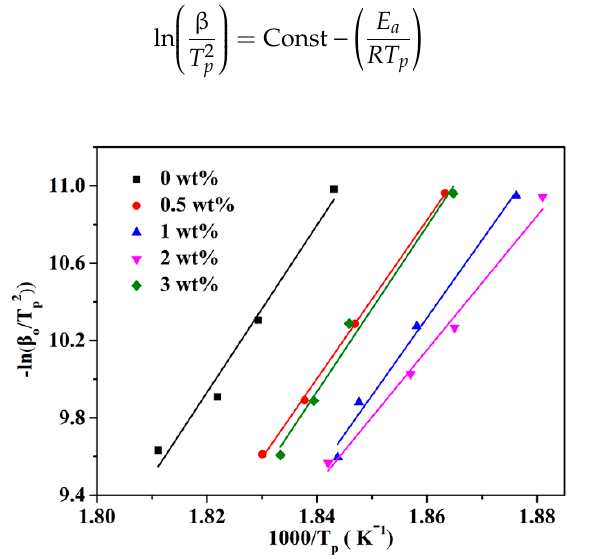
Figure 7. The activation energy of crystallization of various h-BN@(PDA + PEI) nanocomposites.